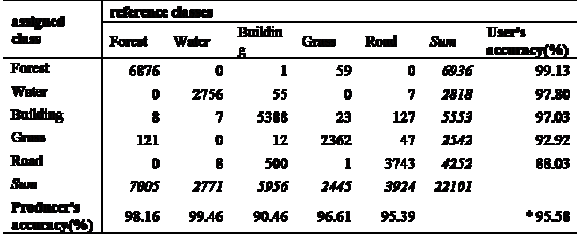
Table 2. Confusion matrix of transformed training